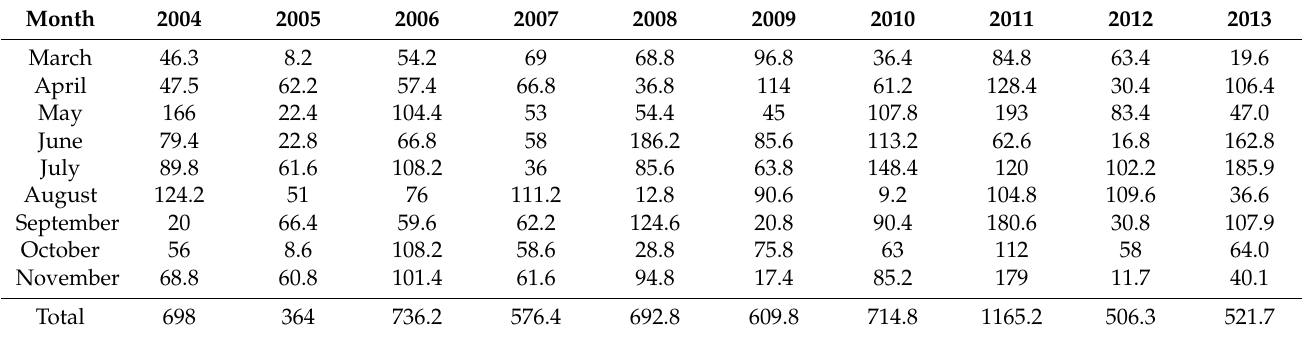
Table 1. Growing seasonal monthly precipitation (mm) on the experimental site, Woodslee, ON, Canada, from 2004 to 2013.